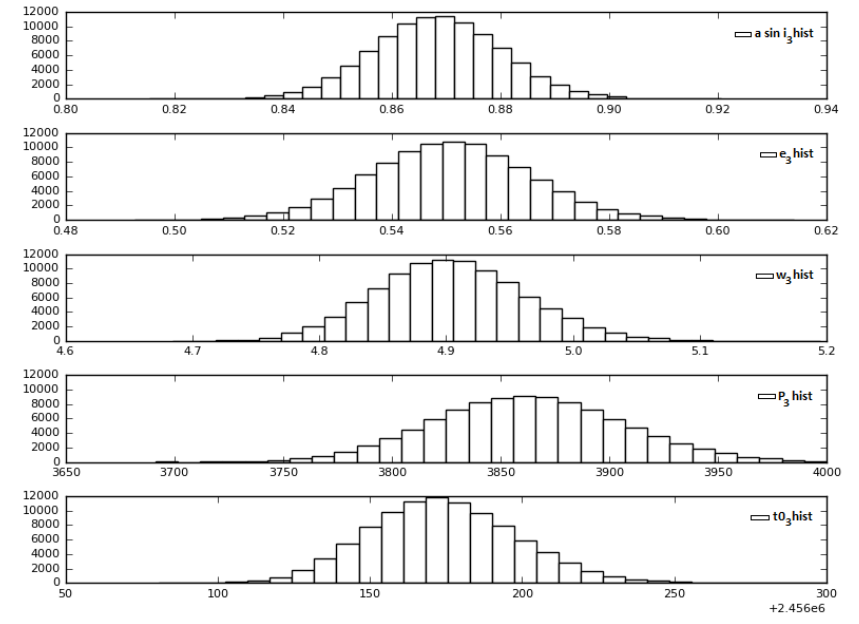
Figure 5. Histograms of parameters resulting from the MCMC chain for the LITE